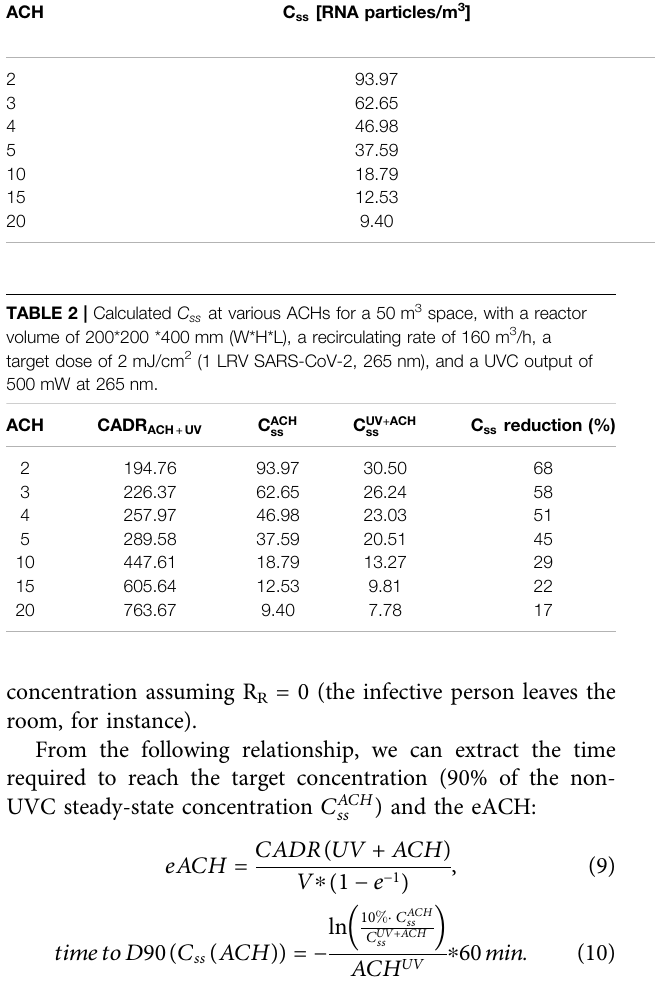
TABLE 1 | Steady-state concentration at different ACHs in a 50 m 3 room and derived time points to 90% reduction for each level and time to 90% reduction of a reference level — here ACH (cid:1) 2 — with increased ACH. ACH C ss [RNA particles/m 3 ]